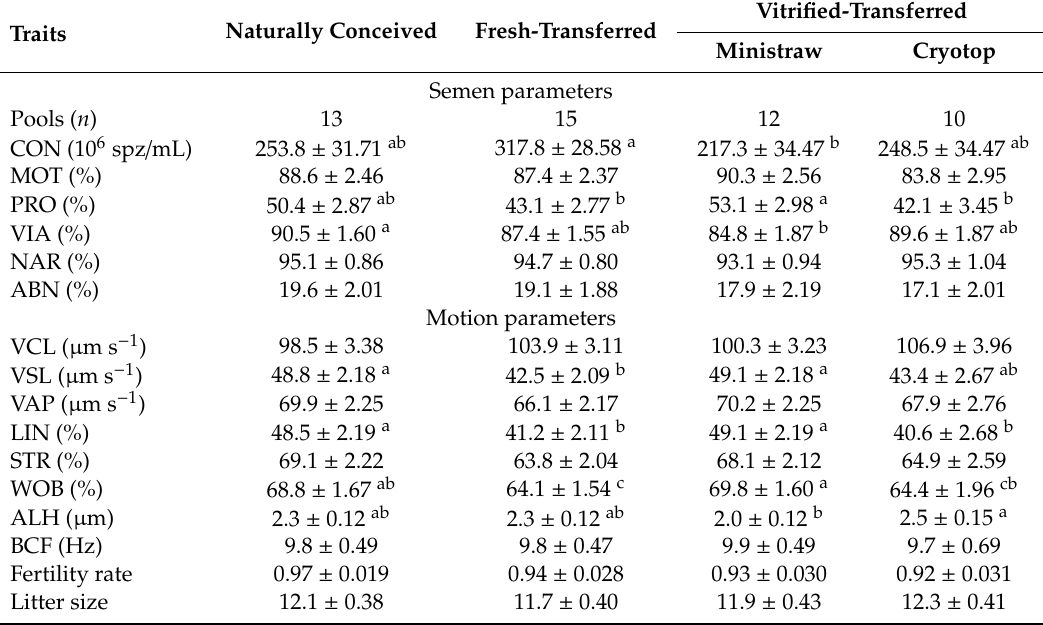
Table 2. Male reproductive performance: comparing di ff erences between naturally conceived males and those born after fresh embryo transfer, vitrified embryo transfer using ministraw, and vitrified embryo transfer using